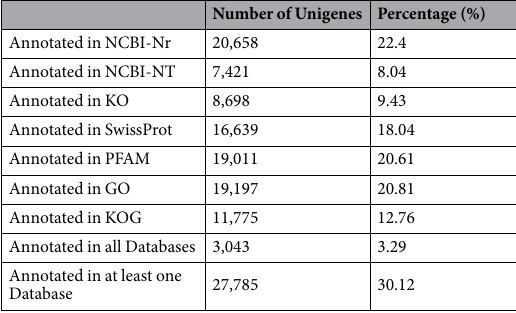
Table 3. Functional annotations of C. ciliata unigenes.